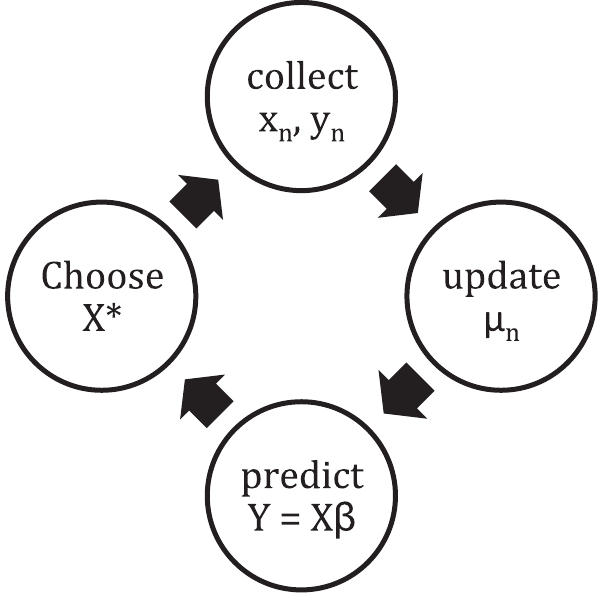
Figure 1. Cycle of MINE discovery – Simplified Computing Life